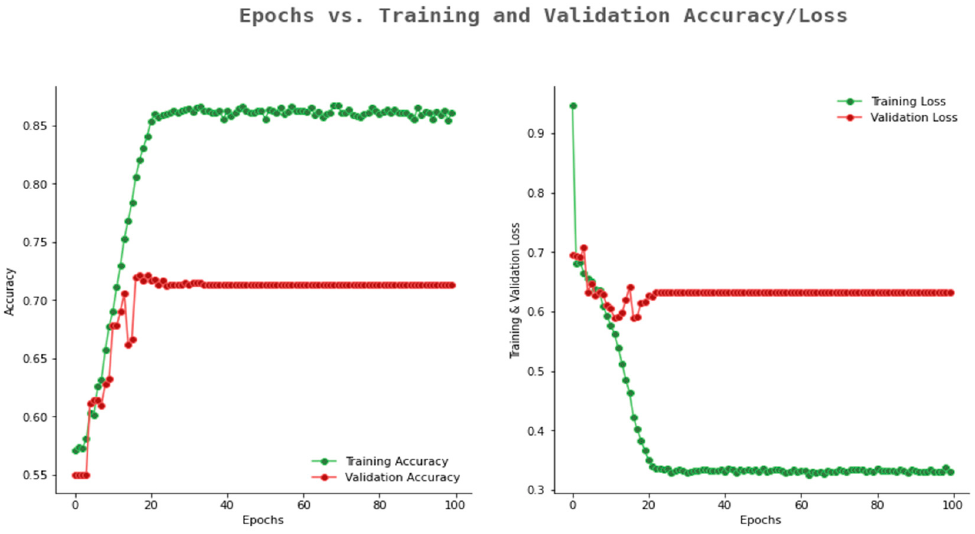
Figure 7. Accuracy and loss graph of VGG16.